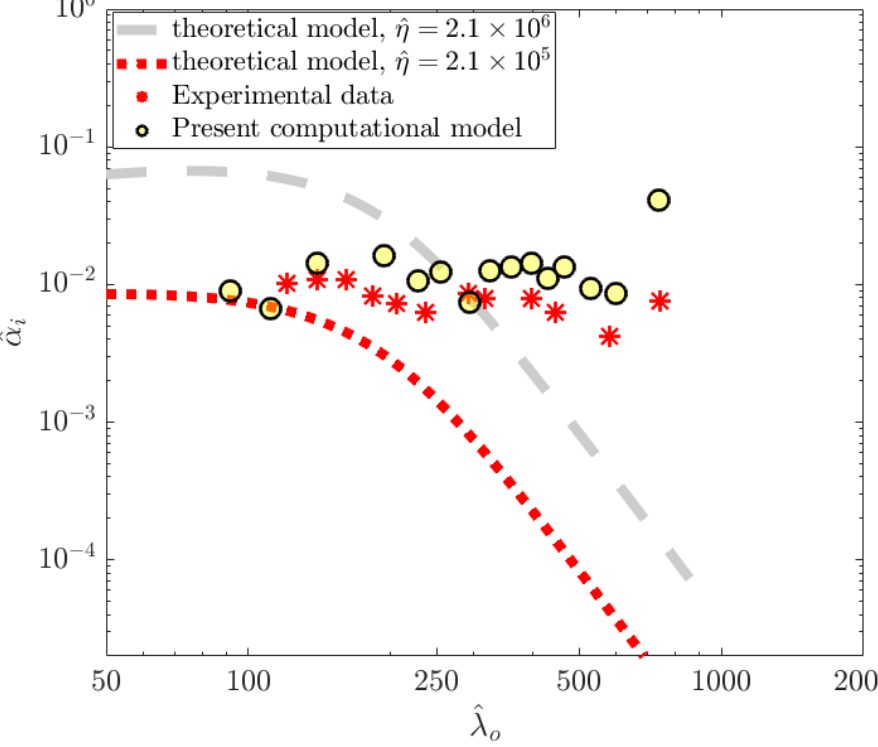
Figure 16. Comparison between decay rate given by the model (o markers) and the measured data (* marker) in the field tests of Voermans et al. [33]. The dashed and dotted curves show the decay rate vs. open-water wavelength curves constructed by using Equation (5).